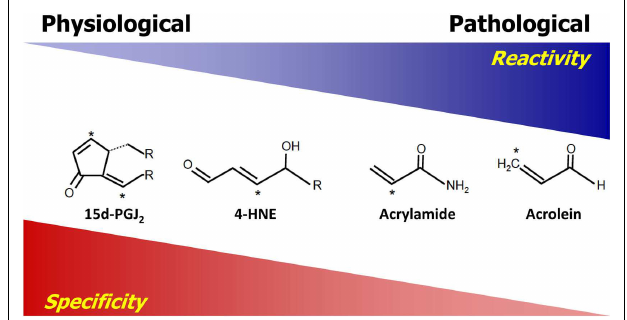
FIGURE 1 | Reactivity versus specificity. The compounds shown are electrophilic and have a very wide spectrum of reactivity.They are listed in order of increasing reactivity from left to right.The relative reactivity is predicted based on previously published reaction rate constants and electrophilicity indexes [see (LoPachin et al., 2007; Rudolph and Freeman, 2009)]. Reactivity is inversely correlated with their specificity in that those on the left are more specific for Cys, which is the most reactive nucleophilic residue in the cell. On the structures listed, the asterisk denotes the electrophilic atom(s) of the